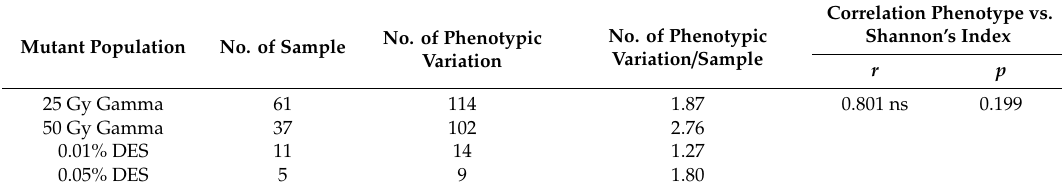
Table 5. Summary of phenotypic variation on di ff erent mutant